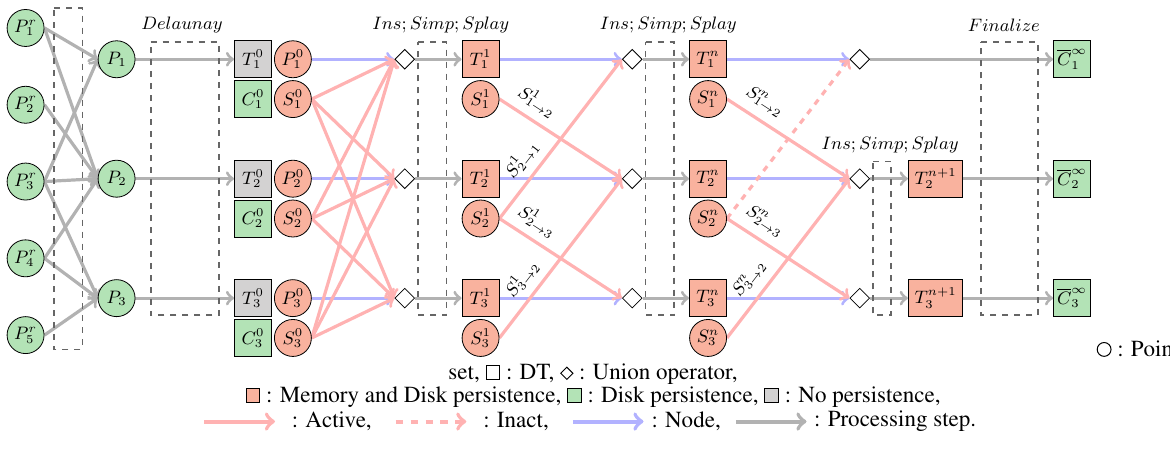
Figure 3. Overview of the distributed Delaunay triangulation workflow in Spark [Caraffa et al., 2019]. The node colors denote the Spark persistence levels of the various